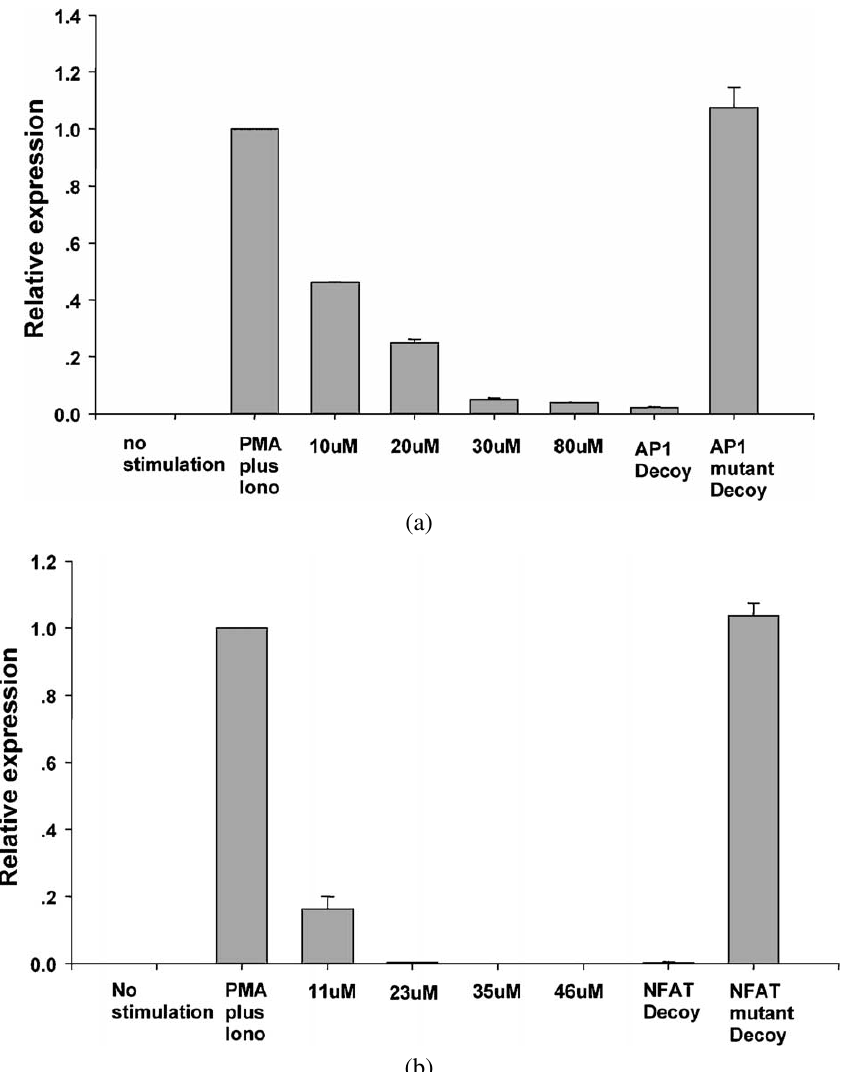
Fig. 3A. (a) The induction of human IL-13Ra2 transcript G in K562 cells by PMA/Iono was inhibited by AP1 inhibitor Sp600125 (in a dose dependent manner) and AP1 decoy ODN, but not mutant AP1 ODN. The expression was evaluated by real-time RT-PCR. Values were normalized to GAPDH and indicated as relative expression. Data are shown as means ± SD of three separate experiments. (b) Induction of human IL-13Ra2 transcript G in K562 cells by PMA/Iono is inhibited by NFAT inhibitor (in a dose dependent manner) and NFAT decoy ODN, but not mutant NFAT ODN. The expression was evaluated by real time RT-PCR. Values were normalized to GAPDH and indicated as relative expression. Data are shown as means ± SD of three separate